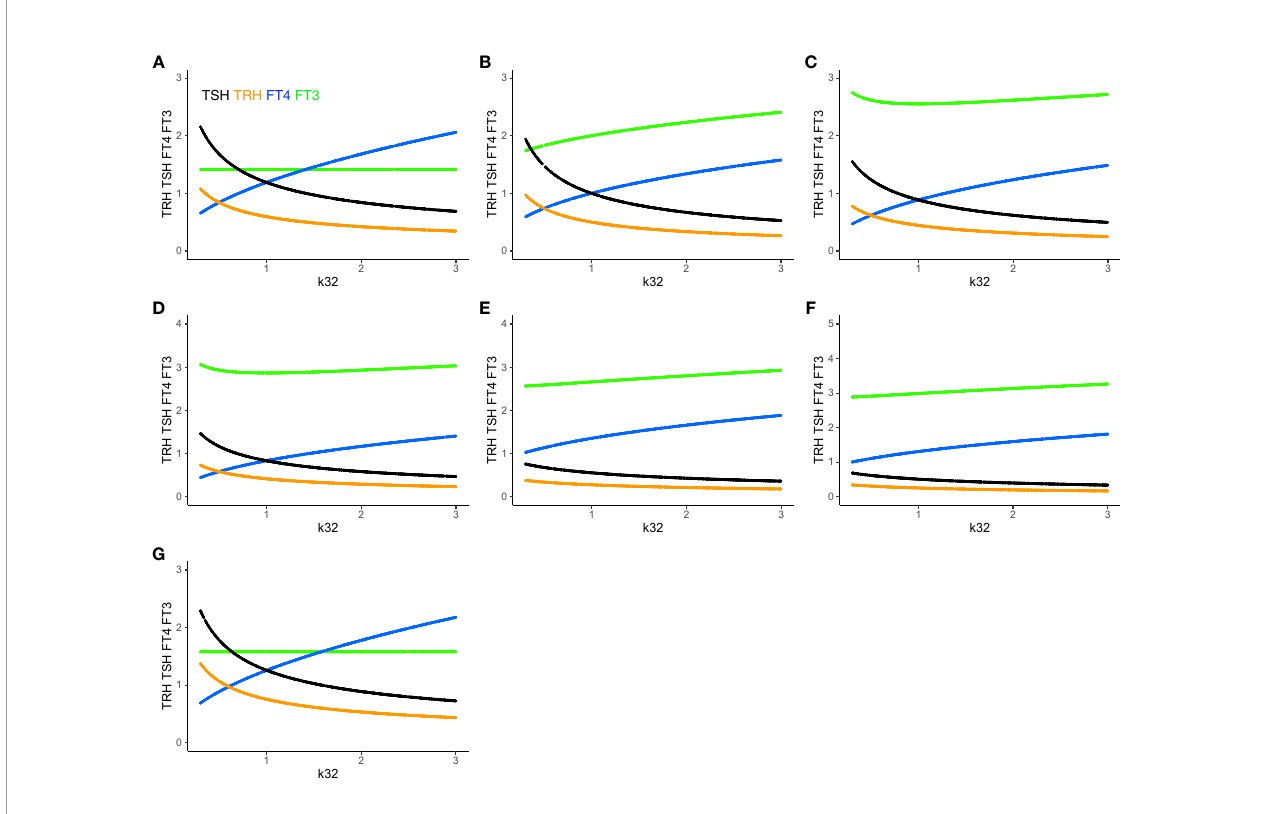
FIGURE 4 | The extended HPT model and mechanisms allowing for adaptation. Unlike (A) system (sys. 1), (B) system (sys. 9), which accounts for additional TSH- independent peripheral (non-thyroidal) FT3 production by various organs, does not preserve FT3 homeostasis. The level of FT3 (green curve) is adapted, as k32 varies, depending on the value of k43 (here k43 = 1). (C) System (sys. 10) additionally accounts for FT4-independent, TSH-dependent thyroidal FT3 production. This mechanism shifts FT3 homeostasis, depending on the values of k32 and k42 (here k42 = 1). It especially protects the level of FT3 against a shortage in the availability of the precursor FT4, when k32 decreases <1. (D) System (sys. 11) introduces a T3 drug, modelled, in the presence of an intact thyroid gland, as a constant external production rate of FT3 (drug 3 = 0.5) (E) introduces in system (sys. 11) a T4 drug as a constant external production rate of FT4 (drug 4 = 0.8), and F ) a combination of both drugs (drug 4 = 0.8, drug 3 = 0.5). The T3 drug is more protective of the FT3 level than the FT4 dug or the combination. (G) In system (sys. 12), which accounts for variation in the TRH production rate constant due to seasonal change, FT3 homeostasis is shifted to a new level depending on the value of ptTSH (here ptTSH=1.5). Color code of hormones: TRH orange, TSH black, FT4 blue, FT3